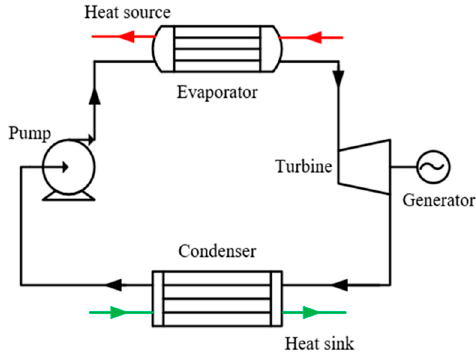
Figure 7. System diagram of simple ORC system.